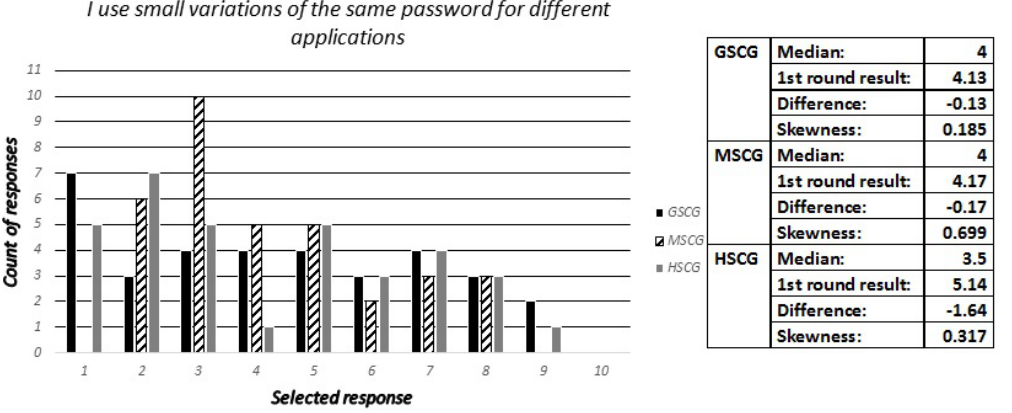
Figure 18. Expert predictions for question 12.